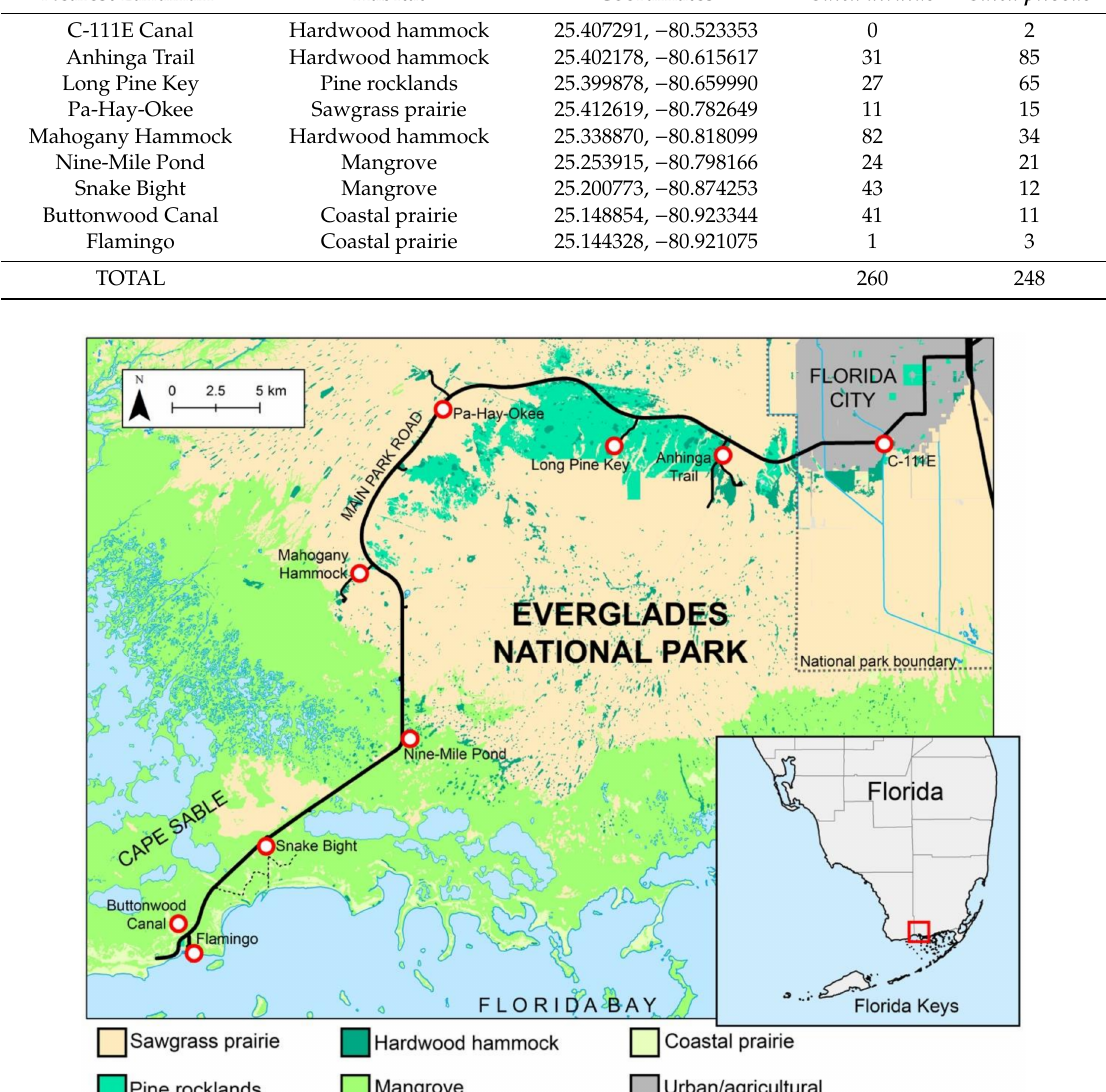
Figure 1. Map of sampling area indicating the sites where blood fed female Culex atratus and Culex pilosus were collected (red circles). The red box in the inset map of the southern Florida Peninsula indicates the figured